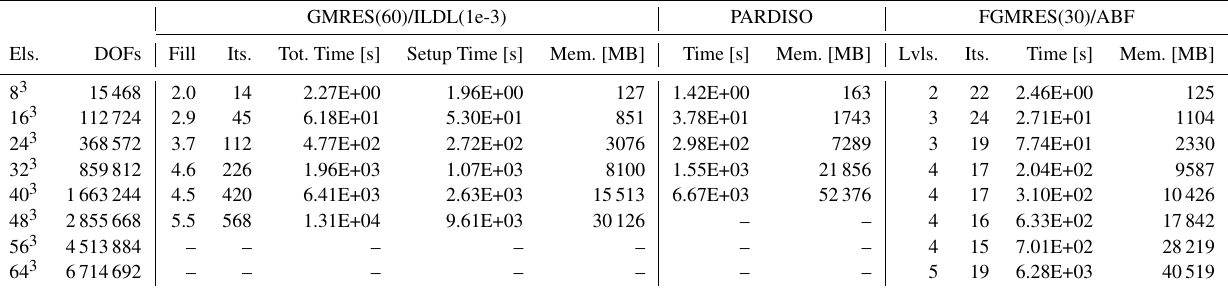
Table 1. Three-dimensional stationary Stokes flow, with three denser (relative density 1 . 2) spherical inclusions of radius 0 . 1 viscosity η 1 /η 0 = 10 4 times higher than in a surrounding medium in the unit cube. Iteration counts accompany data points in the graph. Missing data correspond to runs which failed due to insufficient available memory. See also Fig.